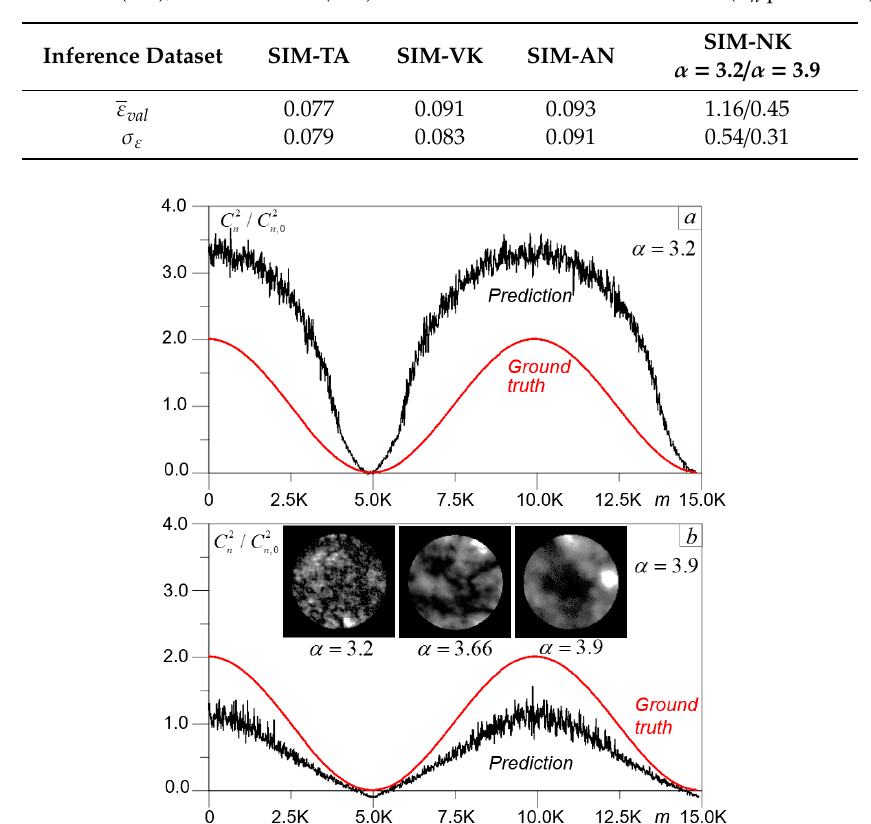
Figure 12. Comparison of C 2 n ground truth vs. prediction in the cross-dataset training-inference machine learning experiments with the Cnˆ2Net training performed using the SIM-KO dataset corresponding to the Kolmogorov turbulence model and inference ( C 2 n prediction) using the SIM- non-Kolmogorov (NK) dataset obtained for the non-Kolmogorov power spectrum model with α = 3.2 ( a ) and α = 3.9 ( b ). Grey-scale images in ( b ) illustrate exemplary scintillation patterns corresponding to C 2 n = 1 · 10 − 14 m − 2/3 . Index m corresponds to scintillation frame stamp number m in the datasets.